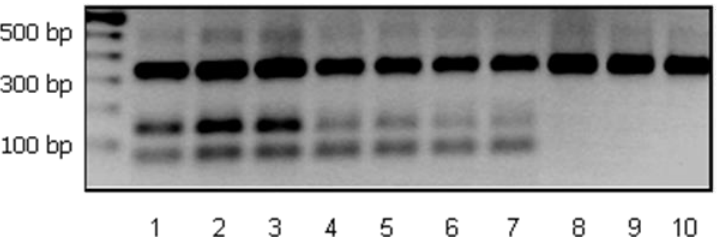
Figure 3. Molecular identification of L. casei ATCC 393 at levels ≥ 6 log cfu / g in probiotic dry-fermented sausages after 66 days of ripening applying strain-specific multiplex PCR assay after lactobacilli enumeration with microbiological analysis. Lane 1: Pure culture of L. casei ATCC 393 served as a positive control. Lane 2: Dry-fermented sausage containing 0.6% sugar and immobilized L. casei ATCC 393. Lane 3: Dry-fermented sausage containing 0.3% sugar and immobilized L. casei ATCC 393. Lane 4: Dry-fermented sausage containing no sugar and immobilized L. casei ATCC 393. Lane 5: Dry-fermented sausage containing 0.6% sugar and free L. casei ATCC 393. Lane 6: Dry-fermented sausage containing 0.3% sugar and free L. casei ATCC 393. Lane 7: Dry-fermented sausage containing no sugar and free L. casei ATCC 393. Lane 8: Dry-fermented sausage containing 0.6% sugar and no starter culture. Lane 9: Dry-fermented sausage containing 0.3% sugar and no starter culture. Lane 10: Dry-fermented sausage containing no sugar and no starter culture.